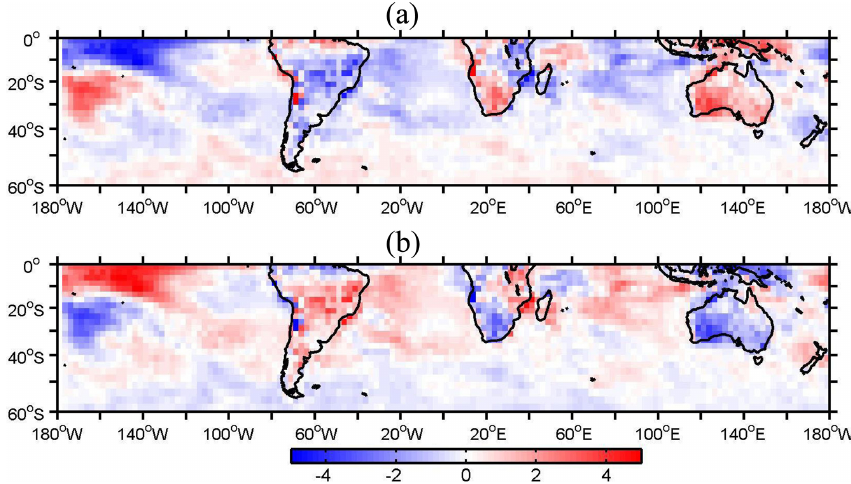
Figure 5. Climatological OLR anomalies (Wm − 2 ) during (a) 1979–1999 and (b) 2000–2020 with respect to the 42-year climatology over the 1979–2020